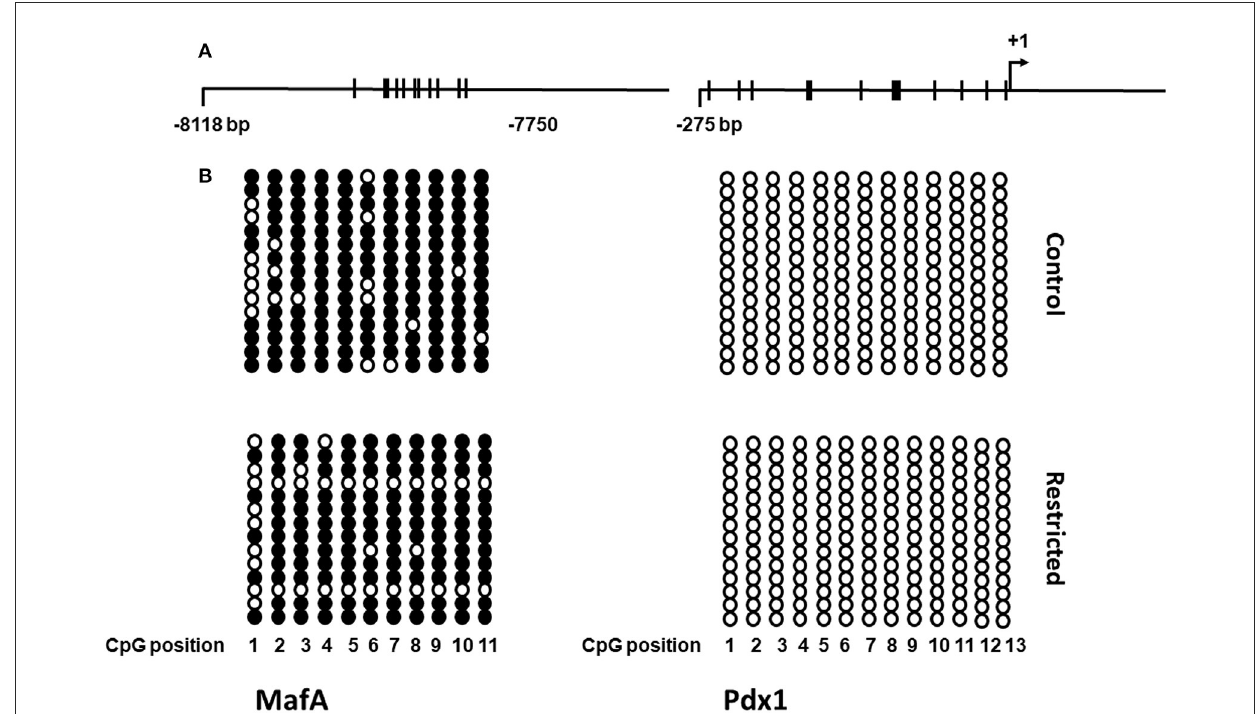
FIGURE7 Schematic representation of the DNA methylation pattern of the MafA and Pdx1 genes in islets from control and restricted offspring. (A) Maps of the regulatory region and proximal promoter of MafA and Pdx1, respectively. Thick bars crossing the main line represent CpG dinucleotides. (B) DNA methylation status in the studied regions of MafA and Pdx1 . Filled circles correspond to methylated CpG sites, empty circles correspond to unmethylated sites, columns represent each CpG site, and rows show all individual clones analyzed. For the scheme, two independent biological samples were